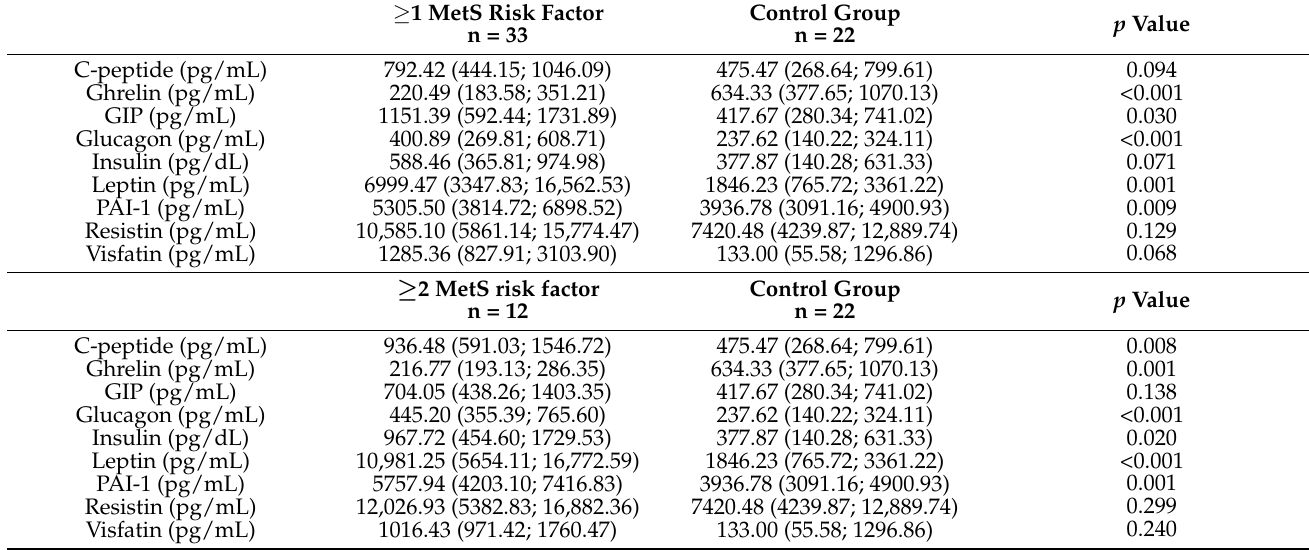
Table 4. Characteristic of acute lymphoblastic leukemia survivors according to number of metabolic risk (MetS) factors compared to the control